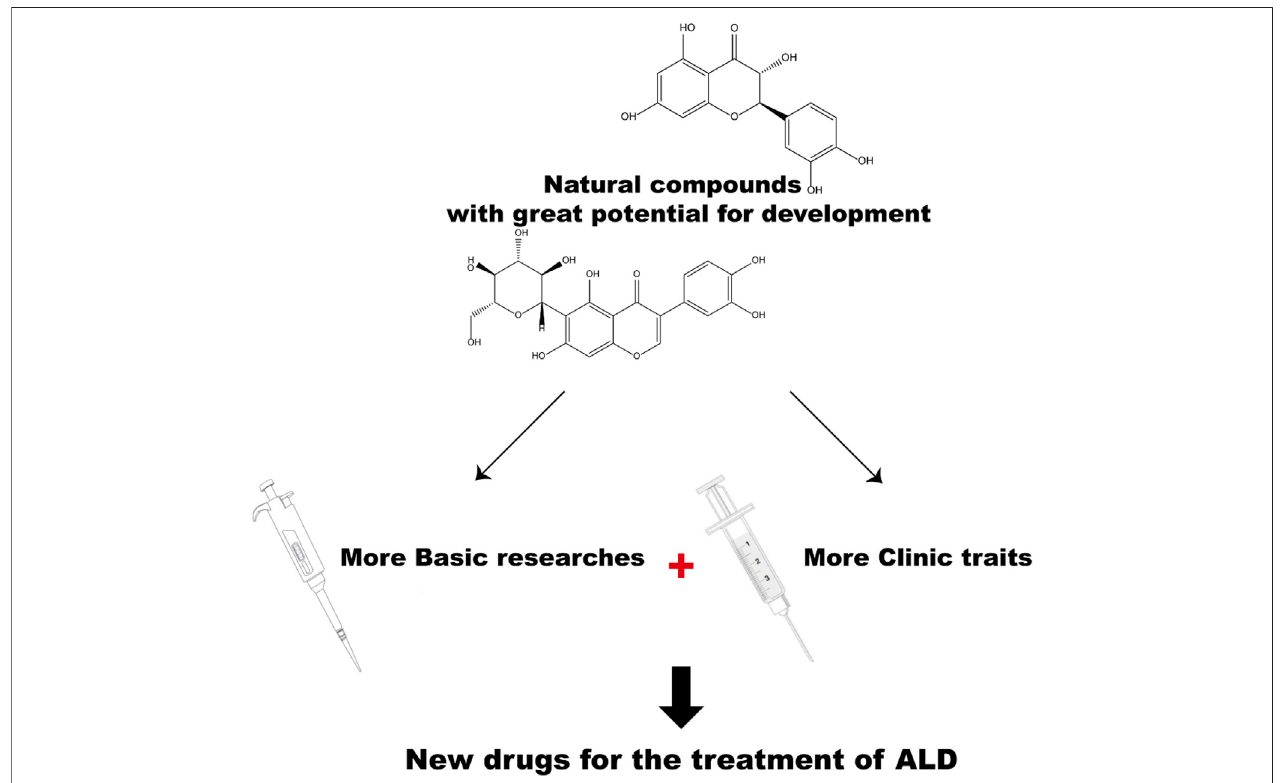
FIGURE 4 | The prospects for developing natural compounds as ALD